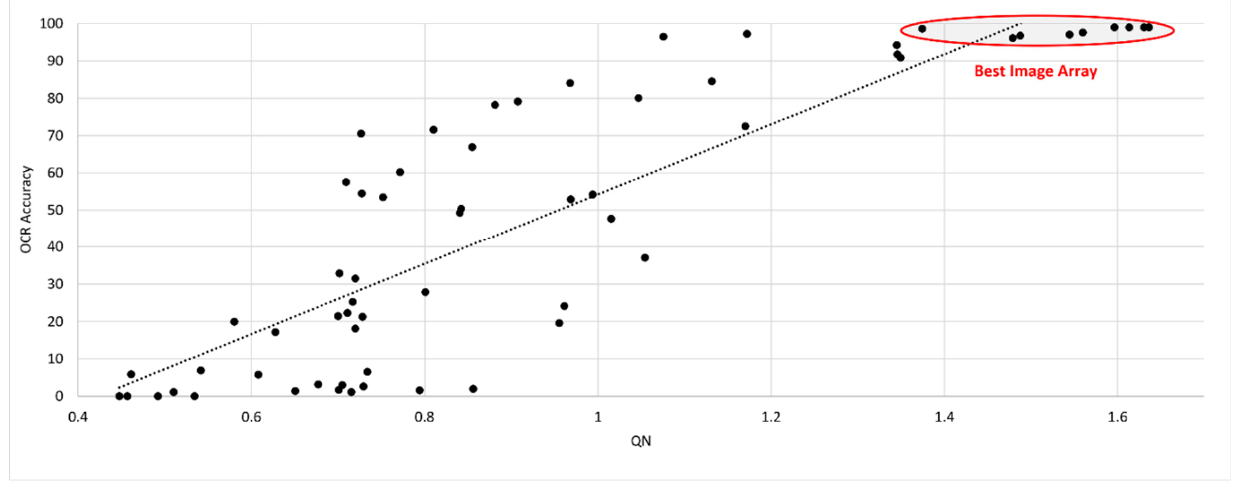
Figure 9. OCR Accuracy vs. Q N for document D1 of the SmartDoc dataset. The system only retains those images in the Best Image Array for conversion to text, but the full results across all versions of the document are presented here.